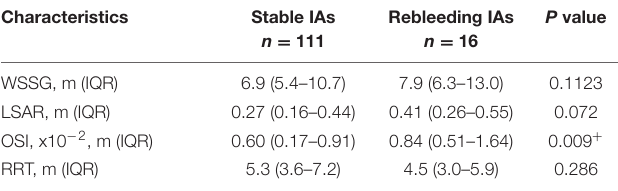
TABLE 5 | The information of patients and IAs in the validation